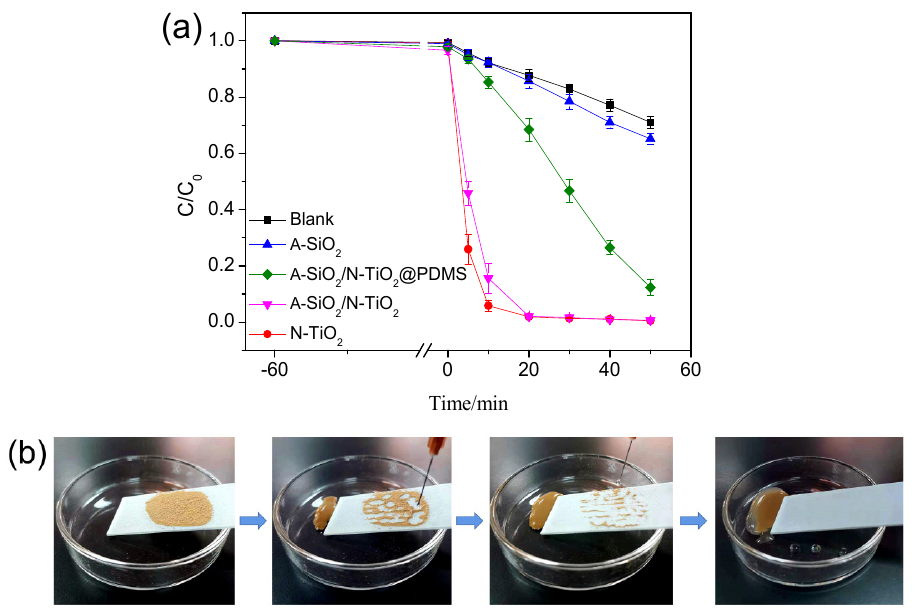
Figure 4. ( a ) Photodegradation of methyl orange by A-SiO 2 /N-TiO 2 @PDMS and other samples; ( b ) simulation experiment of the “lotus effect”.